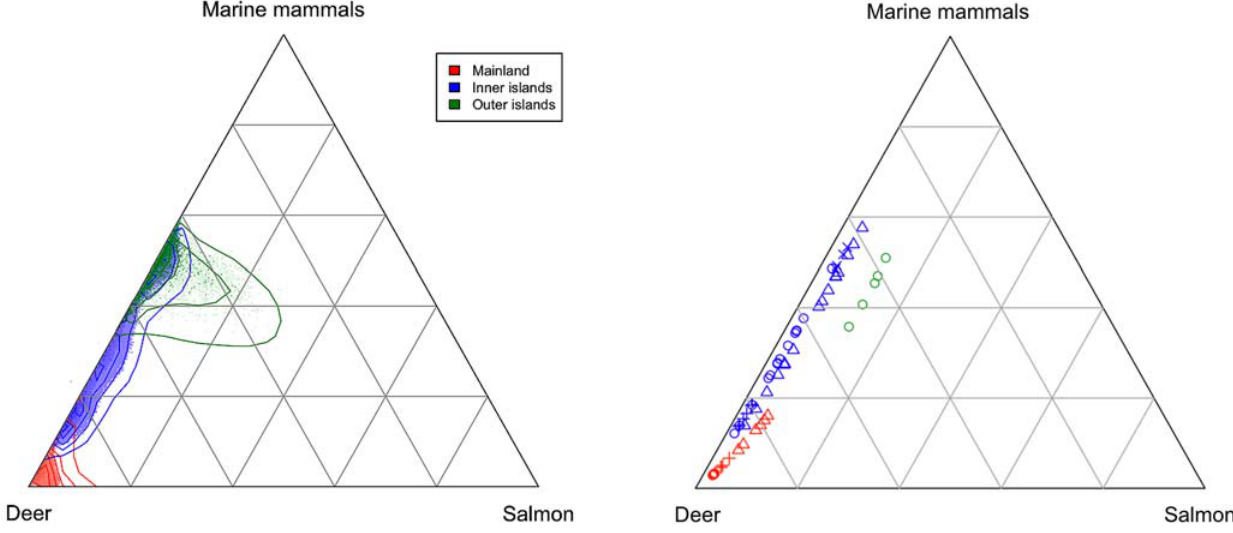
Figure 2. Ternary plots of posterior estimates of the proportional contribution of three prey types to the diet of wolves. Shown are posteriors for each region (aggregated across individuals) and medians (symbols denote group membership for individual wolves).